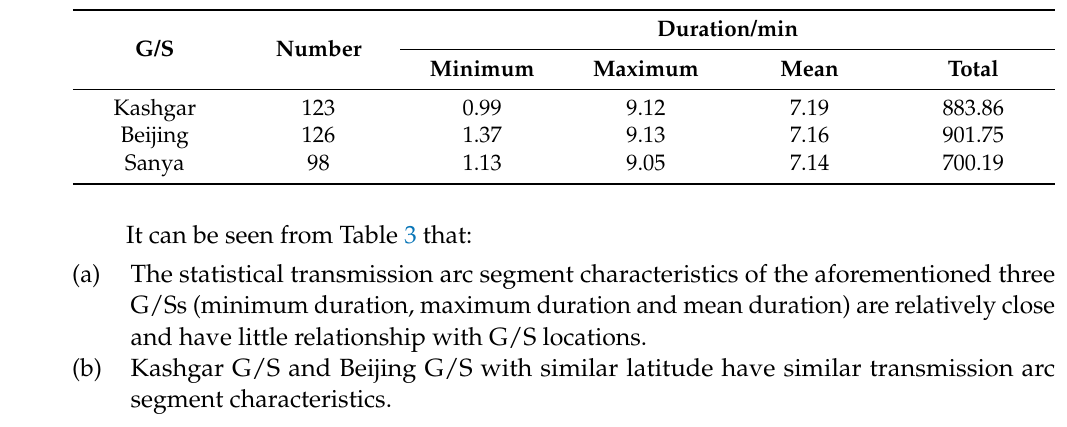
Figure 1. Schematic diagram of transmission arc segment in 31 days. Table 3. Statistic of satellite-to-ground data transmission arc segment in 31